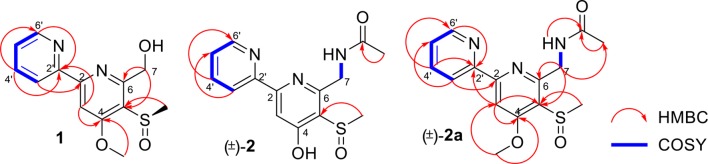
Key 1H-1H COSY and HMBC correlations of 1, (±)-2, and (±)-2a.